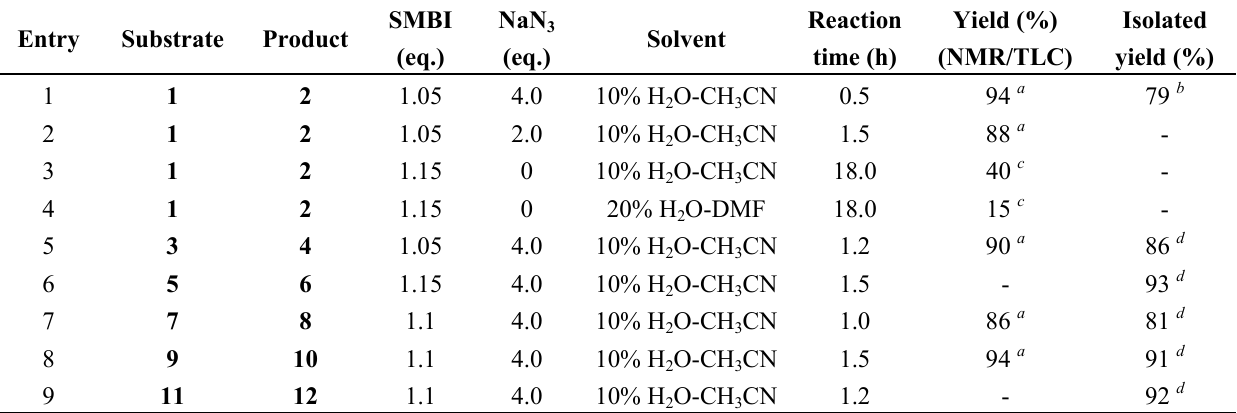
Table 1. Screening for appropriate bromination condition of uridine and bromination of uridine